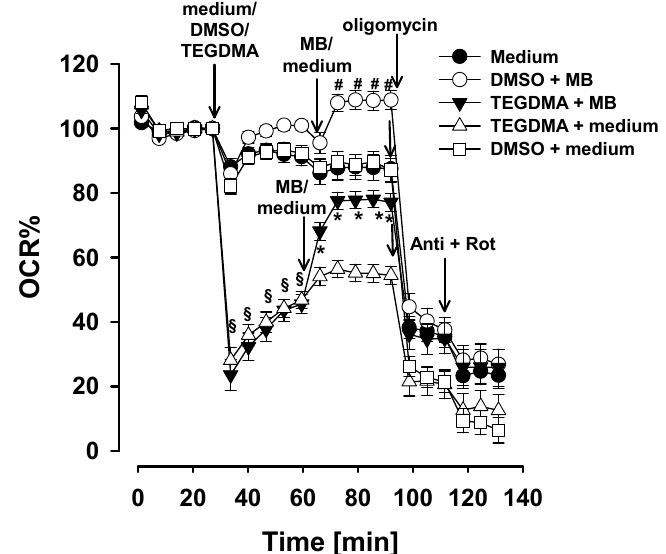
Figure 5. E ff ect of methylene blue (MB) on oxygen consumption of TEGDMA-treated dental pulp stem cells. DMSO, XF medium or TEGDMA (5 mM), MB (2 µ M), oligomycin (2 µ M), antimycin A (Anti; 1 µ M) and rotenone (Rot; 1 µ M) were injected as is indicated. OCR (oxygen consumption rate) is expressed as %. The last data point before TEGDMA or DMSO or medium injection is considered to be 100%. Each point shows mean values of 39–65 parallel wells ± SEM. N = 8. Statistics: § indicates di ff erence between TEGDMA and DMSO + medium p < 0.001. * indicates di ff erence between TEGDMA and TEGDMA + MB p < 0.001; # indicates di ff erence between DMSO + medium and DMSO + MB p < 0.001.